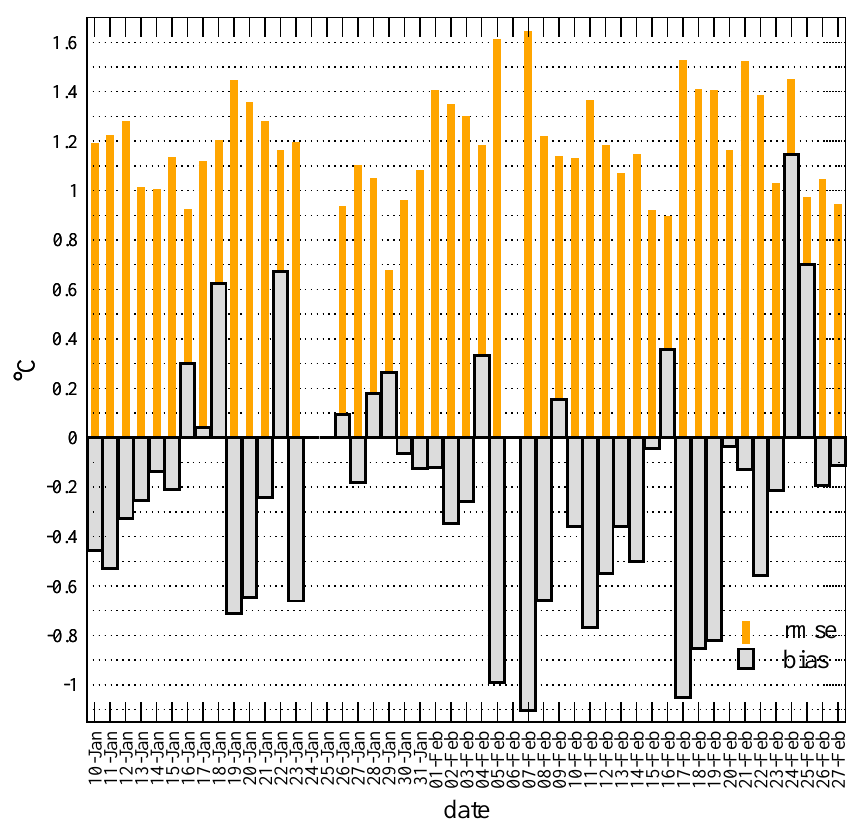
Fig. 3. Daily values of area-averaged BIAS and RMSE for the period of 10 January–27 February